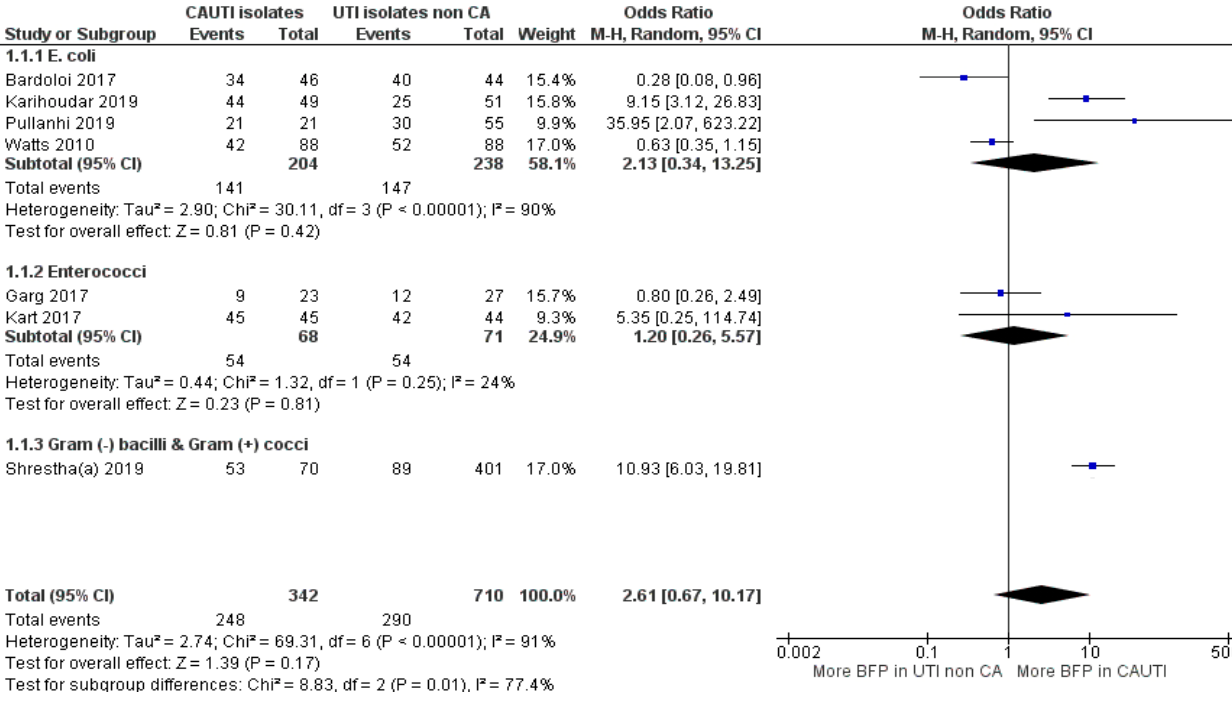
Figure 11. Forest plot of BFP (biofilm production) prevalence in CAUTI vs. non-CAUTI. “Tau 2 ” represents the absolute value of the true variance (amount of heterogeneity). “Chi 2 ” is the chi-squared test of the null hypothesis that there is no heterogeneity. “df” are degrees of freedom. “P” represents the p -value. The “I 2 ” statistic describes the percentage of variation across studies that is due to heterogeneity rather than chance. “Z” is the z-statistic, which are significance tests for the weighted average effect size. “CI” stands for confidence interval. “M-H” is the Mantel-Haenszel analysis method.